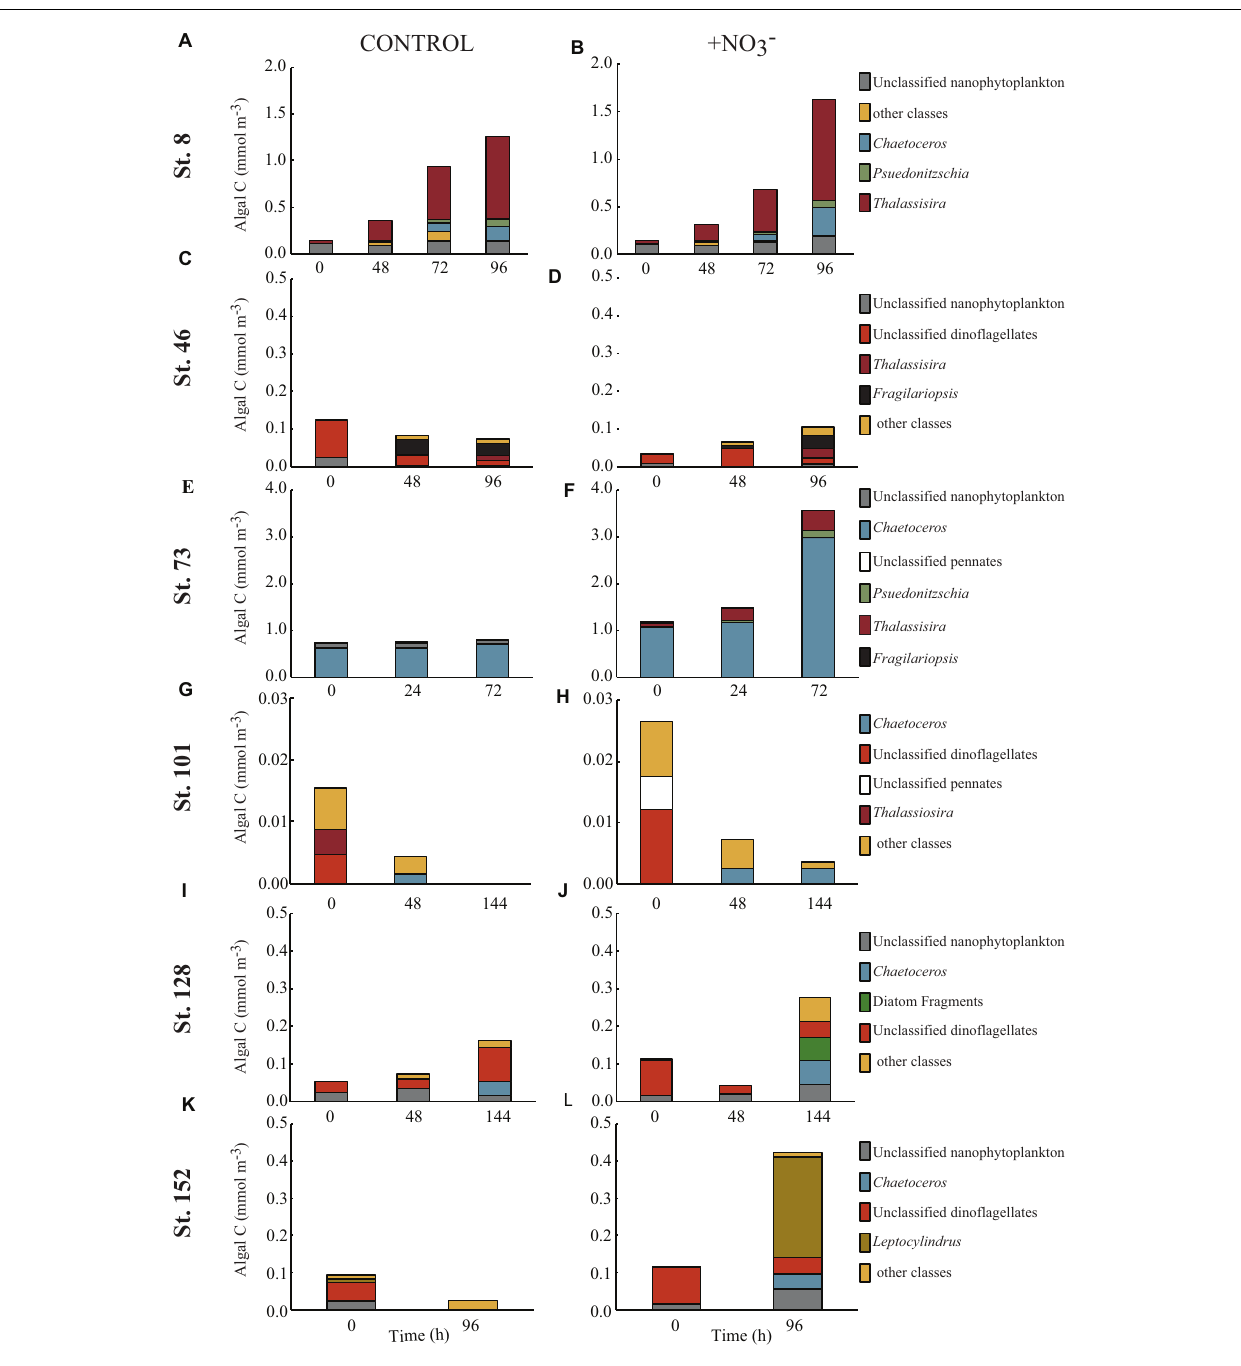
site, both the control and treated waters increased two–threefold in POC and PON while at the latter site POC and PON remained unchanged in both the control and treated